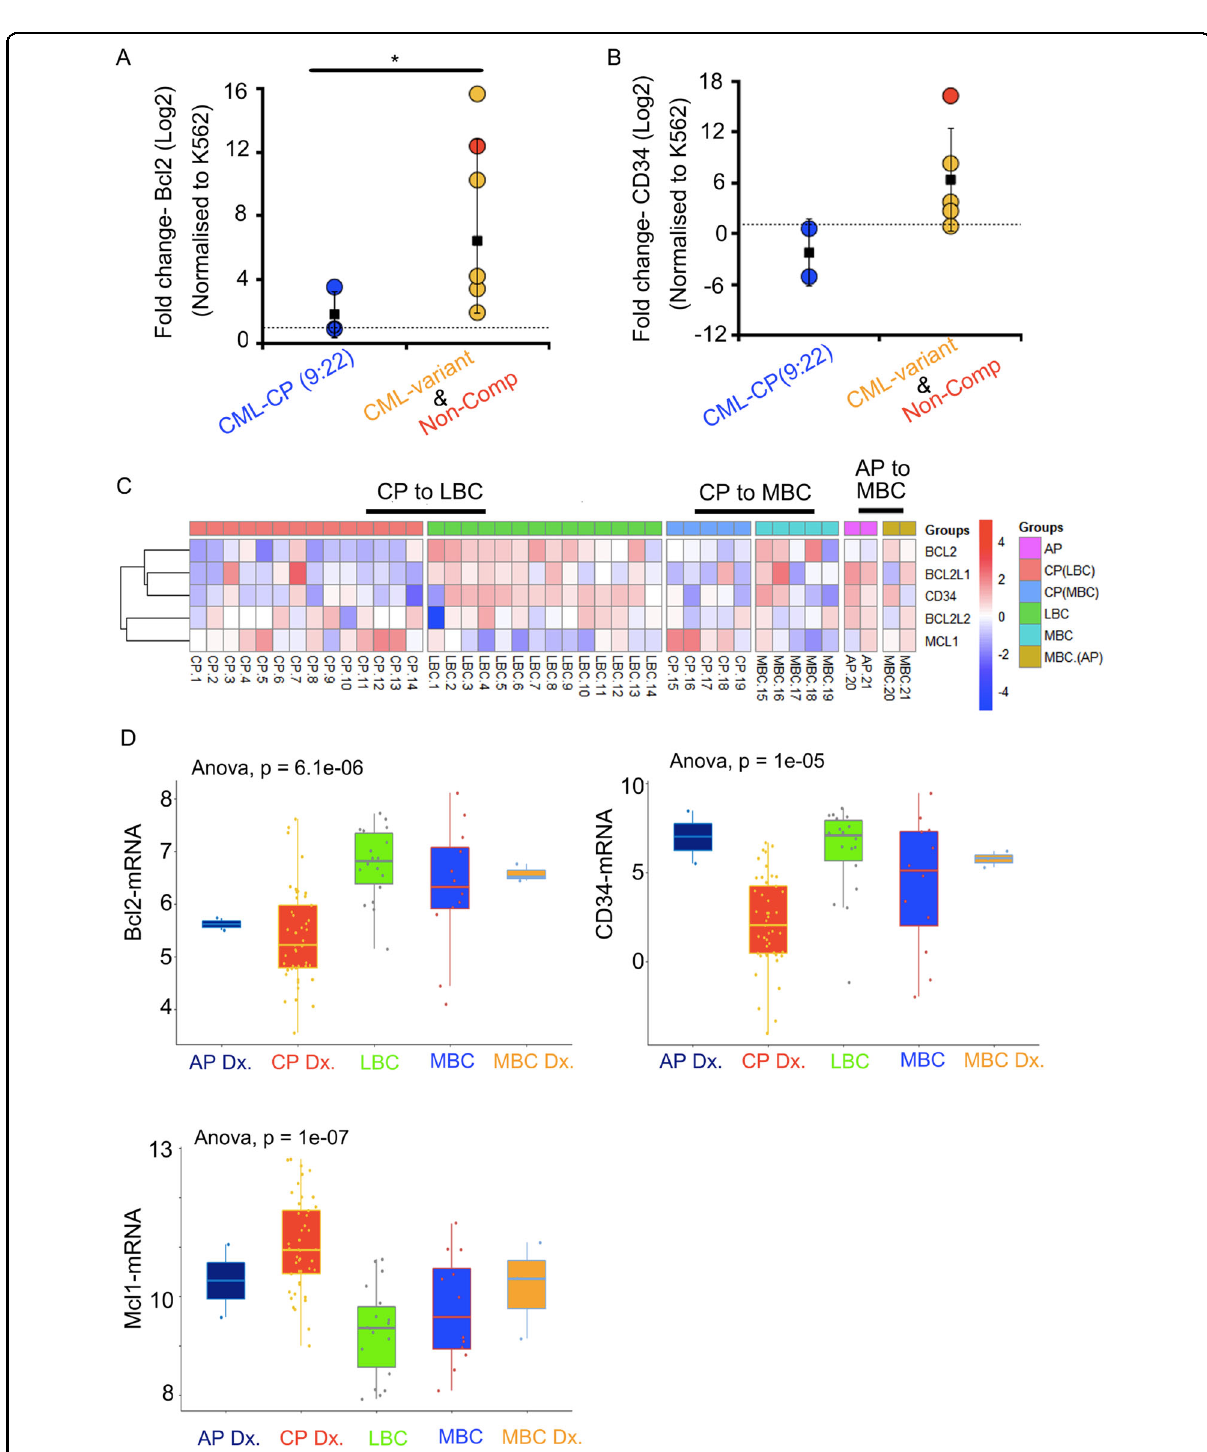
Fig. 4 Bcl2 and CD34 are upregulated in progressive CML patients. A RT-PCR data representing fold change in Bcl2 and CD34 levels using BM aspirates derived from CML patient samples ( y -axis = log2 scale). B Heatmap demonstrating relative expression pro fi le of anti-apoptotic genes (Bcl2, Bcl2l1/Bcl-xL, Bcl2l2/Bcl-w) and stem cell marker (CD34) using matched CML samples. Most of the patients were in chronic phase at diagnosis (CP Dx.) with progression to lymphoid Blast crisis (LBC) or myeloid blast crisis (MBC). Two patients were in accelerated phase at diagnosis (AP Dx.) and progressed to MBC. The pattern of expression signi fi es the change in the trend of regulation of BCL2, BCl2L1, CD34, MCL-1 in progressive, poor responder CML patients. C Boxplot representing the distribution of Shh target genes BCL2, Mcl-1, and CD34 expression at various stages of the disease using data from Branford et al. D Signi fi cant upregulation of Bcl2 ( P value = 6.1 × 10 – 6 ) and CD34 ( P value = 1 × 10 – 6 ) in LBC is observed, while Mcl-1 expression is downregulated in progressive cases. Statistical analysis done using one-way ANOVA